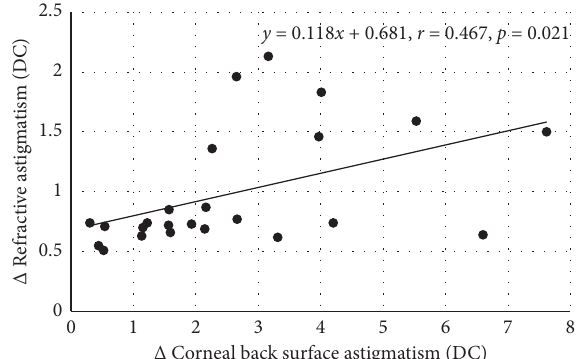
Figure 2: Change in astigmatism at the corneal back surface over the central 3mm zone ( x axis) and the corresponding change in residual refractive astigmatic error determined by autorefrac- tometry ( y axis) between 2 and 3 months postoperatively. All units are in diopters.